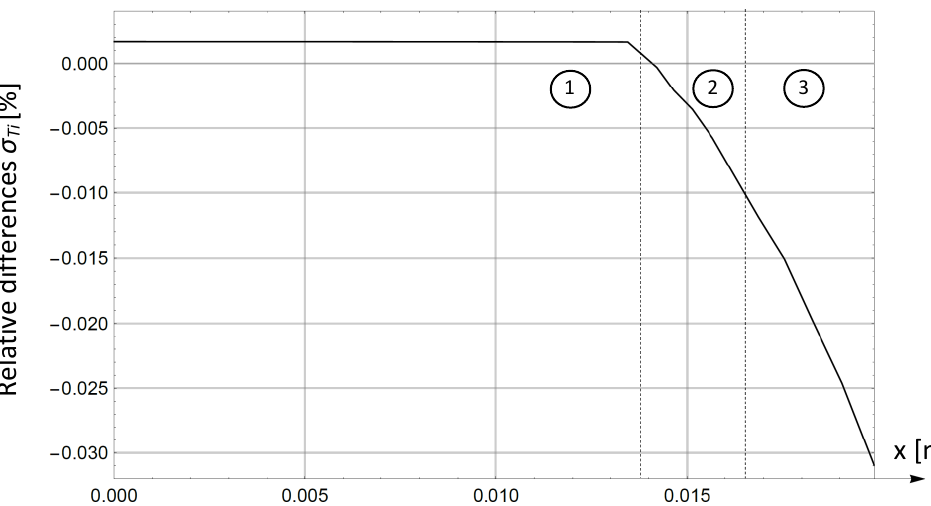
Figure 7. The relative differences (34) on the major semi-axis ( y = 0).